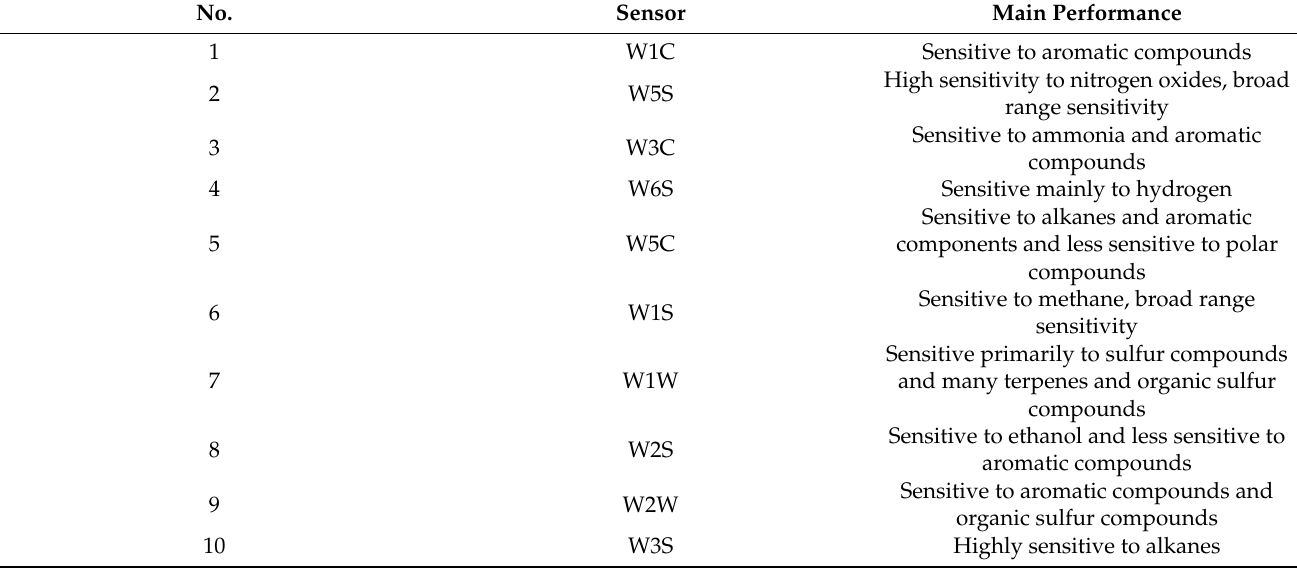
Table 3. Sensor array details